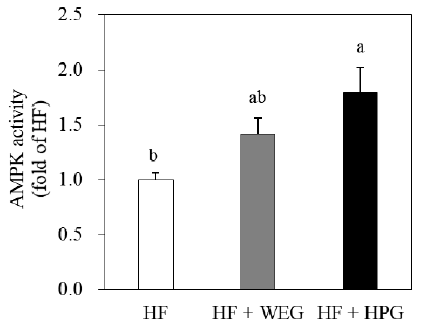
Figure 7. Effects of WEG and HPG on adenosine monophosphate-activated protein kinase (AMPK) activity in WAT. Values are expressed as mean ± SEM ( n = 9/group). a,b Mean values with unlike superscript letters are statistically different at p < 0.05. HF: high fat; WEG: hot water extract of ginger; HPG: high-hydrostatic pressure extract of